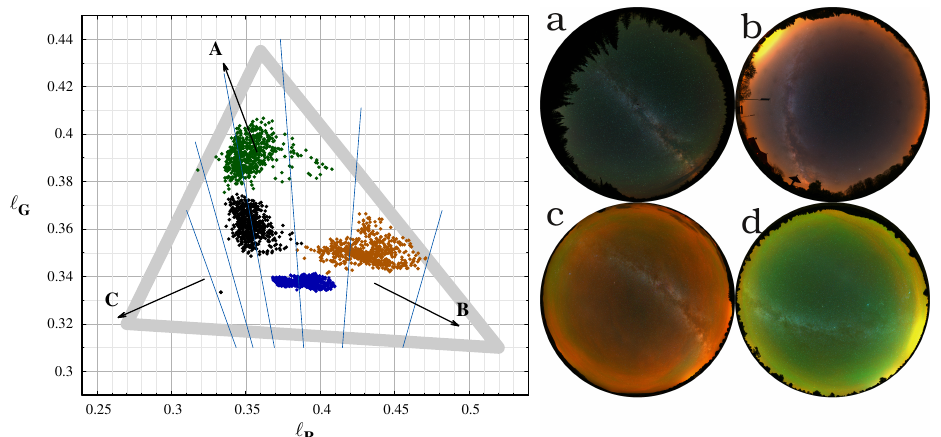
Figure 6. Left: The measured colours from four different situations. The most probable colour range is indicated by the grey triangle. The arrows indicated the possible shifts by different sources: ( A ): Green oxygen airglow, ( B ): Sodium airglow, ( C ): Twilight. Right: false colour enhanced all sky images at the four location: ( a ): Ontario, Canada (black), ( b ): Zselic (blue), ( c ): Cosmic campground (orange), ( d ): El Malpais (green). the colour names in parenthesis gives the symbol colours in the left image. The cyan lines indicates the regions with equal CCT from 3000K ( right ) to 5500K ( left ) in 500K steps.